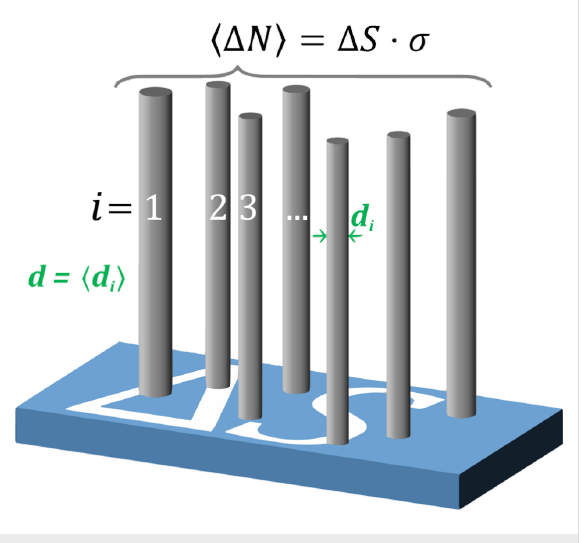
Figure 2: Schematic illustration of the geometrical model used to ap- proximate an array of randomly distributed, vertically aligned, high- aspect-ratio nanocylinders of a mean diameter d and a surface num- ber density σ . A flat substrate with an area Δ S is shown with a mean number of nanocylinders estimated as the product of Δ S and σ